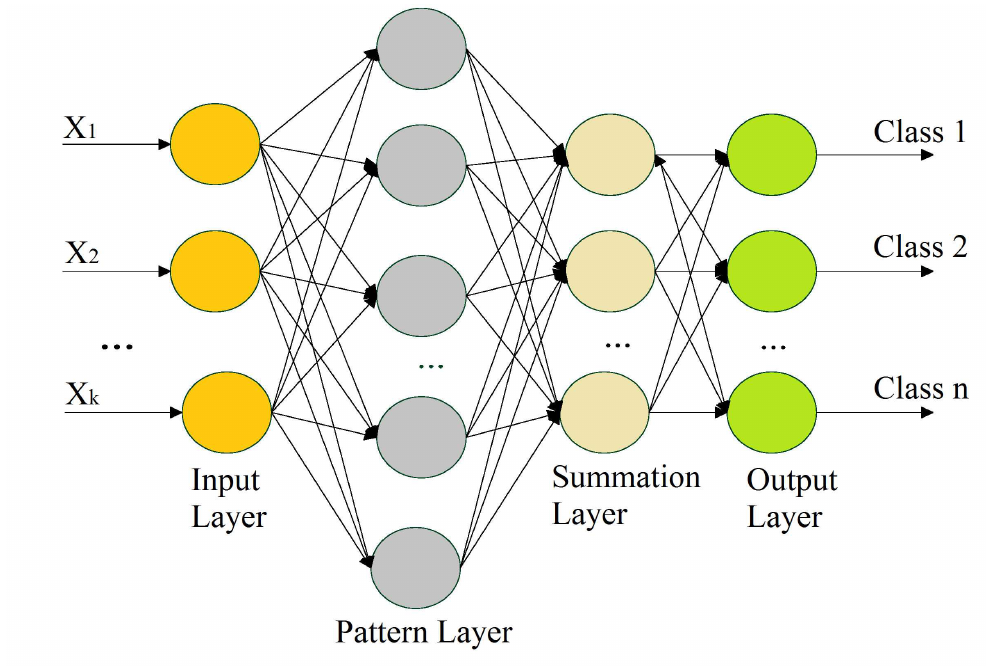
Figure 5. Illustration of a probabilistic neural